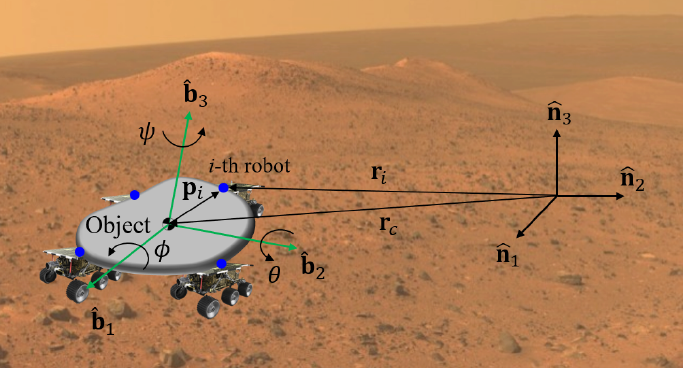
Figure 2. Definitions for frames and